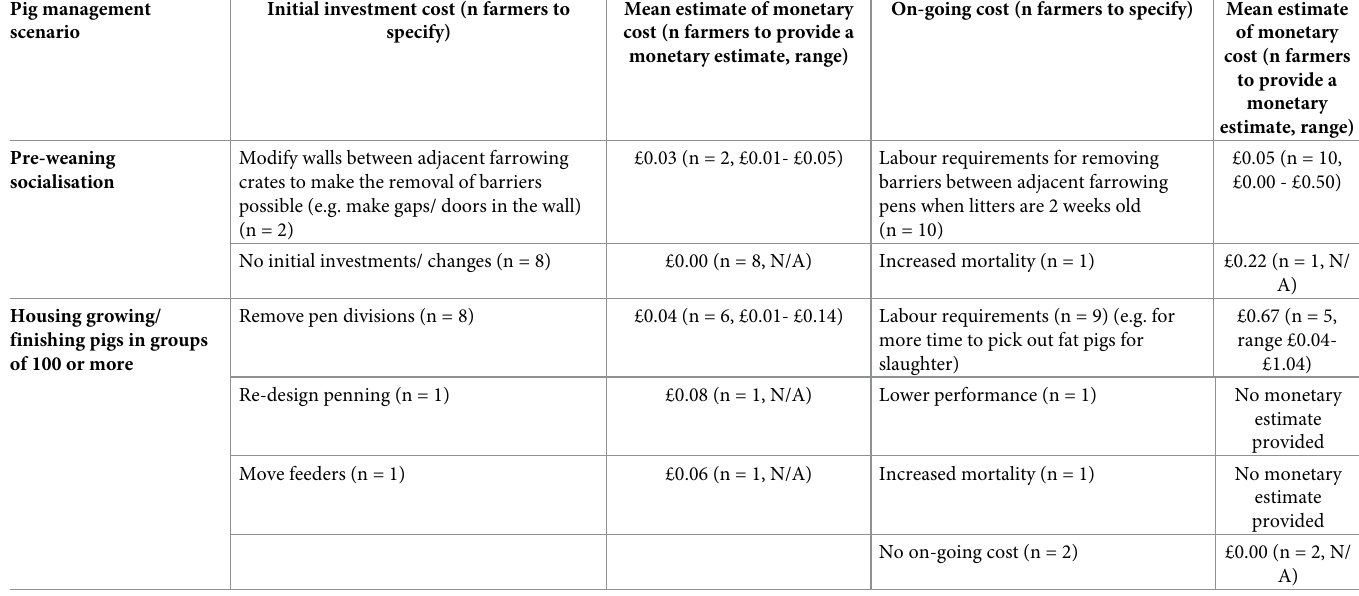
Table 2. Farmers’ survey responses regarding the estimation of initial investment costs and on-going costs likely to arise when implementing each aggression con- trol strategy. Pig management scenario